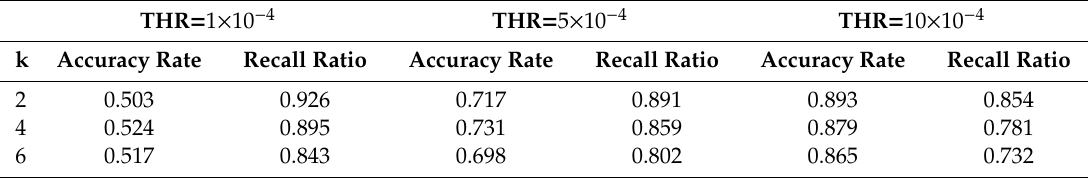
Table 1. The detection results of the Mahalanobis distance under di ff erent